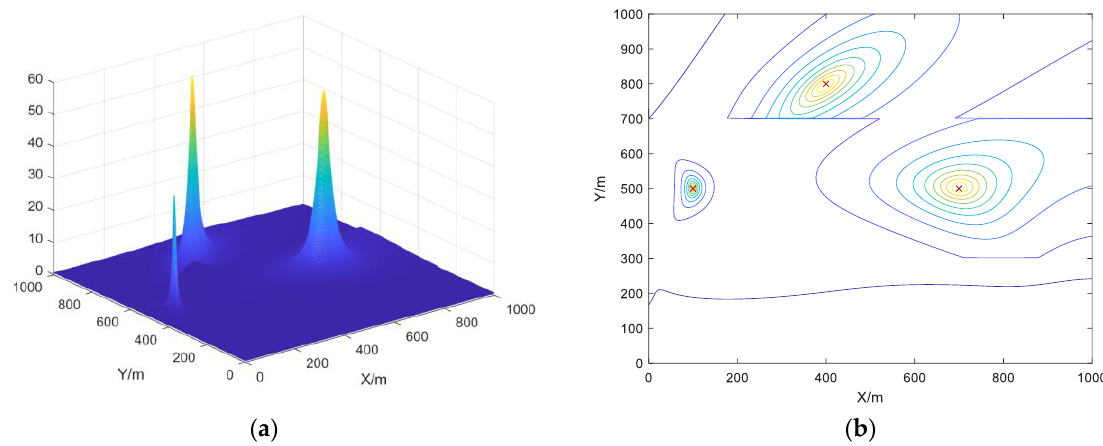
Figure 3. ( a ) Location spectral peak map; ( b ) contour map.